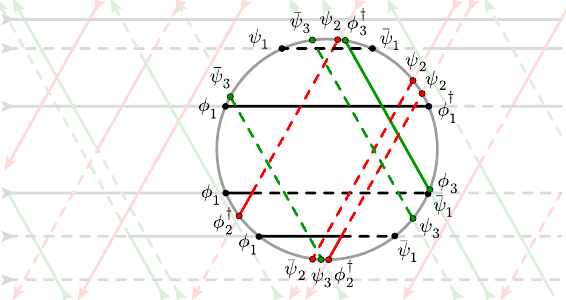
(cid:22) (cid:22) y y (cid:30) 3 (cid:22) 1 3 (cid:22) 1 (cid:30) y (cid:30) 1 ]( x 1 : : : x 20 ), and the 1 2 2 (cid:30) 2 (cid:30) 1 (cid:30) 3 1 2 3 2